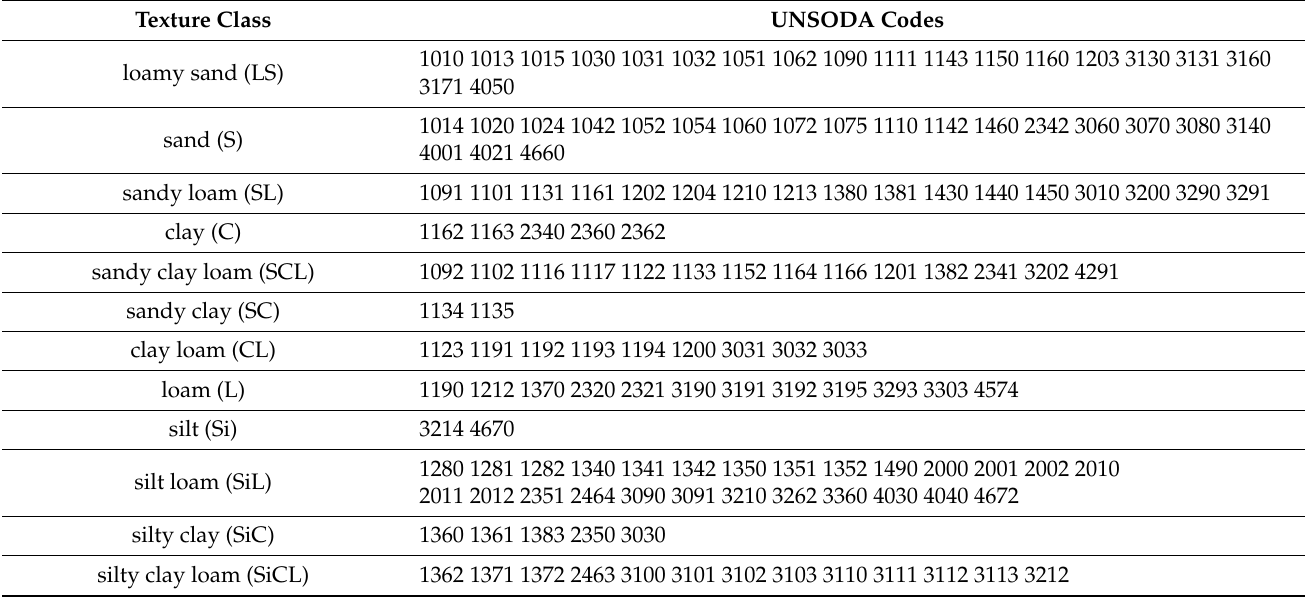
Table 1. Code and texture classes of UNSODA soil